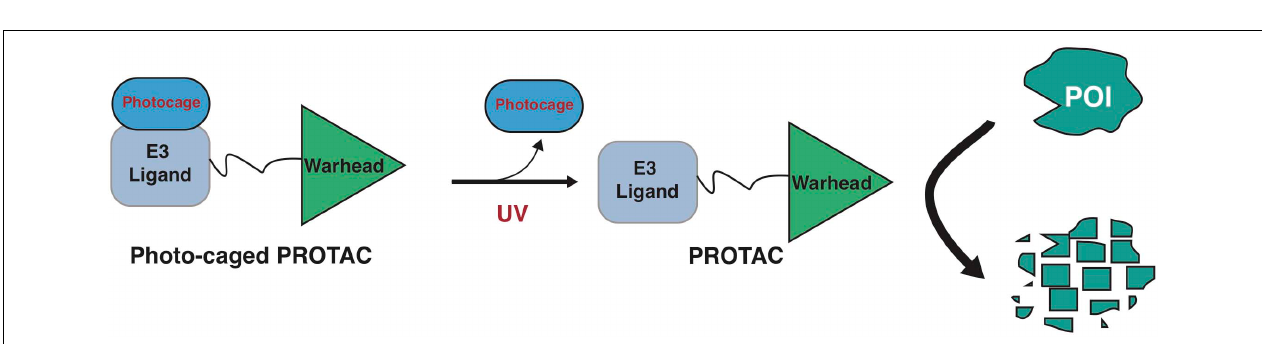
FIGURE 1 | A schematic diagram for the action model of PROTAC. PROTAC recruits endogenous E3 ligase to ubiquitinate protein of interests (POIs), thus promoting the subsequent degradation of POI by the 26S proteasome.